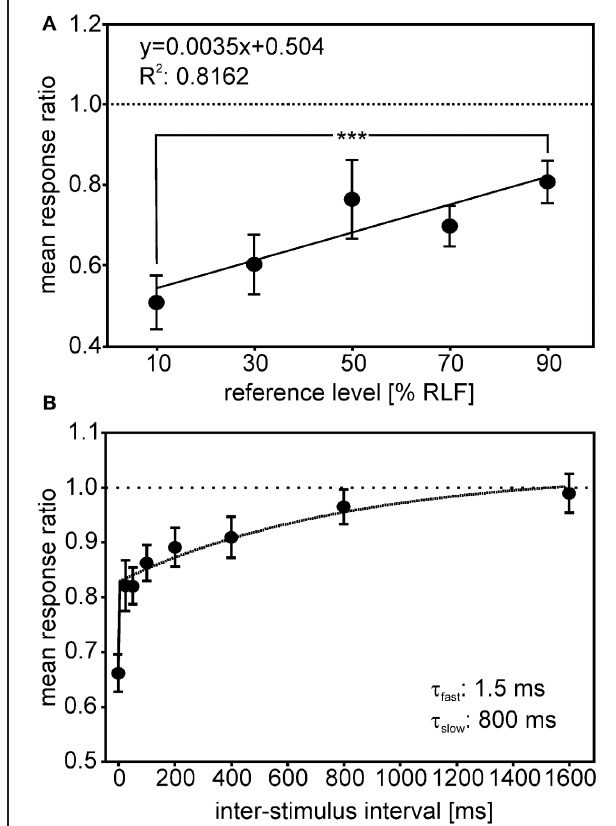
FIGURE 9 | Adaptation in ICC. The response ratio, defined as the quotient of the unit’s response rate to a given probe (second stimulus), divided by the response rate of a particular reference-stimulus (first stimulus), is plotted. (A) The mean response ratios as a function of the relative reference-stimulus level. Probe and reference stimulus had the same level. The reference level refers to the dynamic range as determined from the rate-level function (RLF). The responses ratios decreased with decreasing reference level and differed significantly between 90 and 10% reference-stimulus level (Mann–Whitney test, P < 0 . 0001). (B) Responses ratios as a function of the interstimulus interval (ISI) tested. Response ratios were significantly reduced compared with unity for ISIs up to 400ms (one-sample t -tests, all P < 0 . 05; significance levels are indicated as follows: P < 0 . 05: ∗ ; P < 0 . 01: ∗∗ ; P < 0 . 001: ∗∗∗ ). The recovery function could be fitted well ( R 2 = 0 . 982) by a double exponential with a short time constant of 1.25ms and a long time constant of 800ms (see inset in B